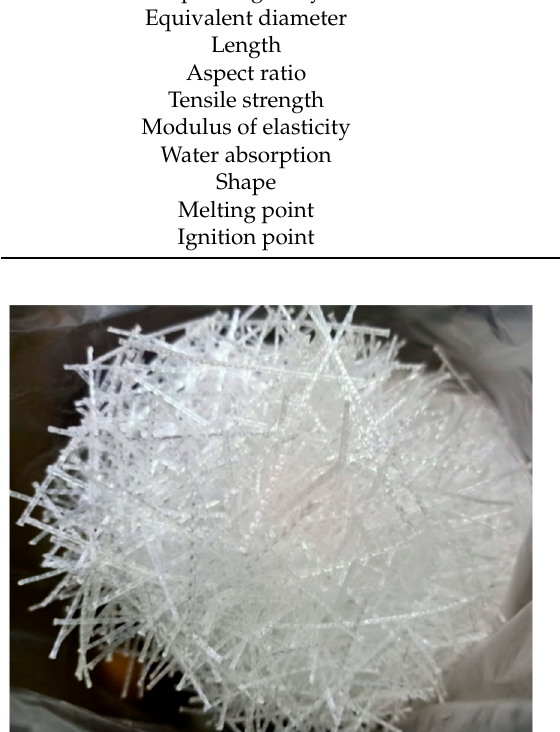
Figure 1. Structural macro synthetic polypropylene